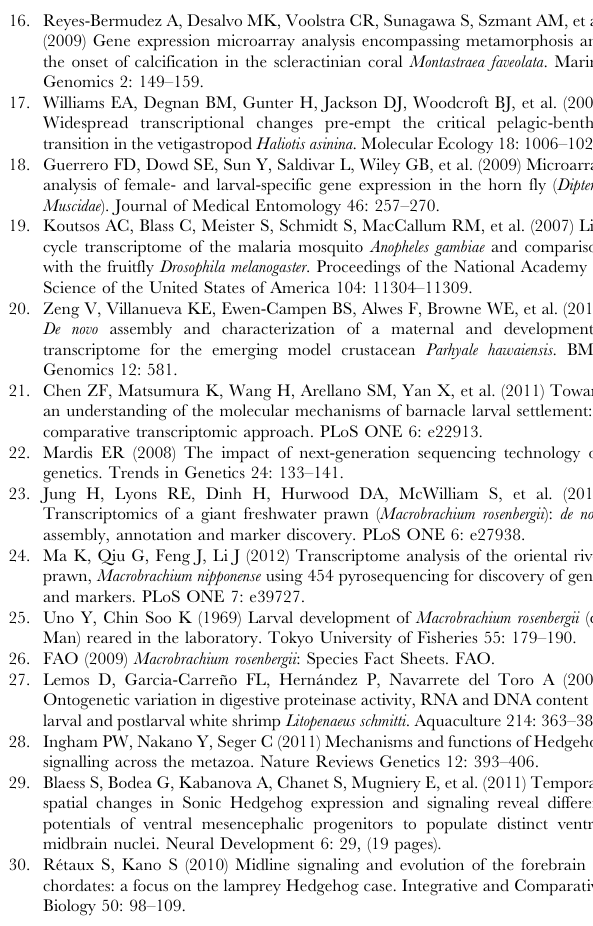
Figure S5 Best three BLASTP Results for Mr-Patched, Mr-Wnt5, Mr-Fz and Mr-CYP15A1